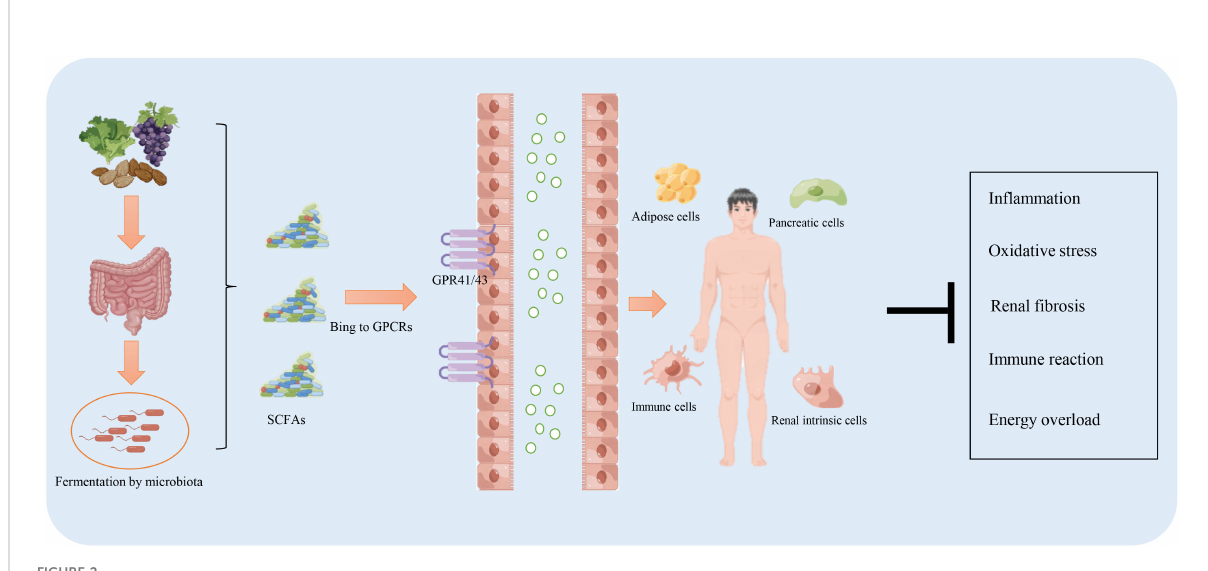
FIGURE 2 The function of short-chain fatty acids (SCFAs) in the prevention and treatment of diabetic kidney disease. The intake of a high- fi ber diet promotes the production of SCFAs through fermentation by the microbiota residing in the digestive system. SCFAs facilitate resistance to in fl ammation, the immune response, energy overload, and renal fi brosis mainly via binding to G protein-coupled receptors